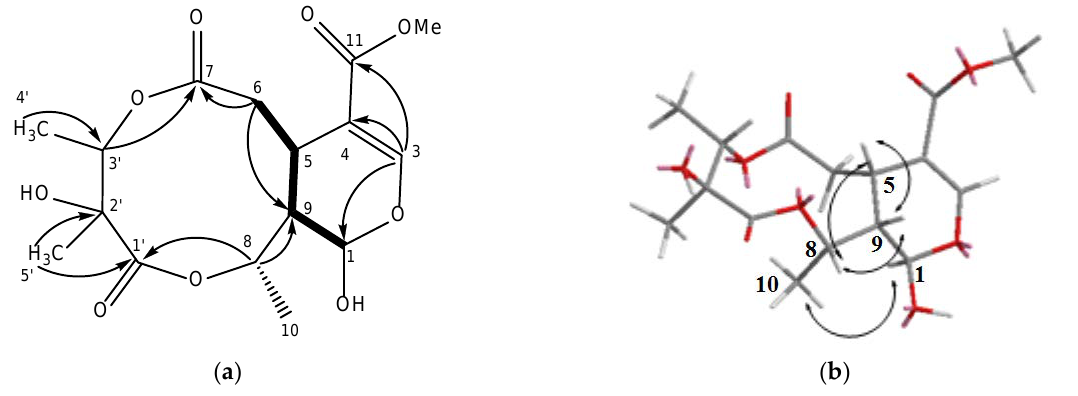
Figure 2. ( a ) The structure of metabolite 1 and selected 1 H– 1 H COSY ( ▬ ) and HMBC ( → ) correlations. ( b ) Selective NOESY correlations of 1 .